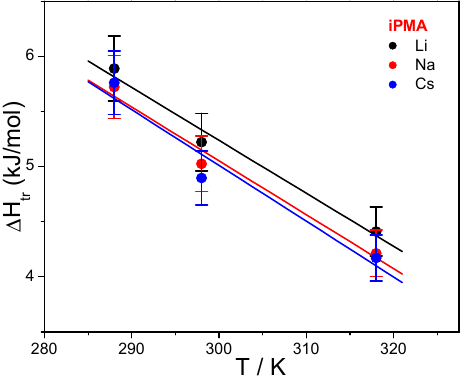
Figure 8. The enthalpy change, ∆ H tr , accompanying the transition of iPMA chains from the uncharged to the charged state in 0.01 M aqueous XCl solutions (X = Li, Na, Cs) as a function of temperature.